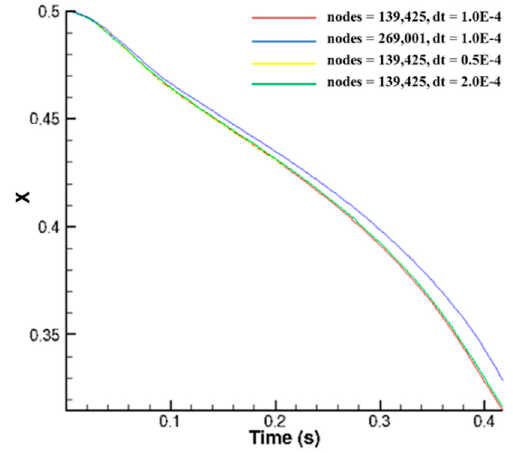
Figure 4. The x-coordinate of the first particle as a function of time for two different mesh resolutions and three different time-step sizes.